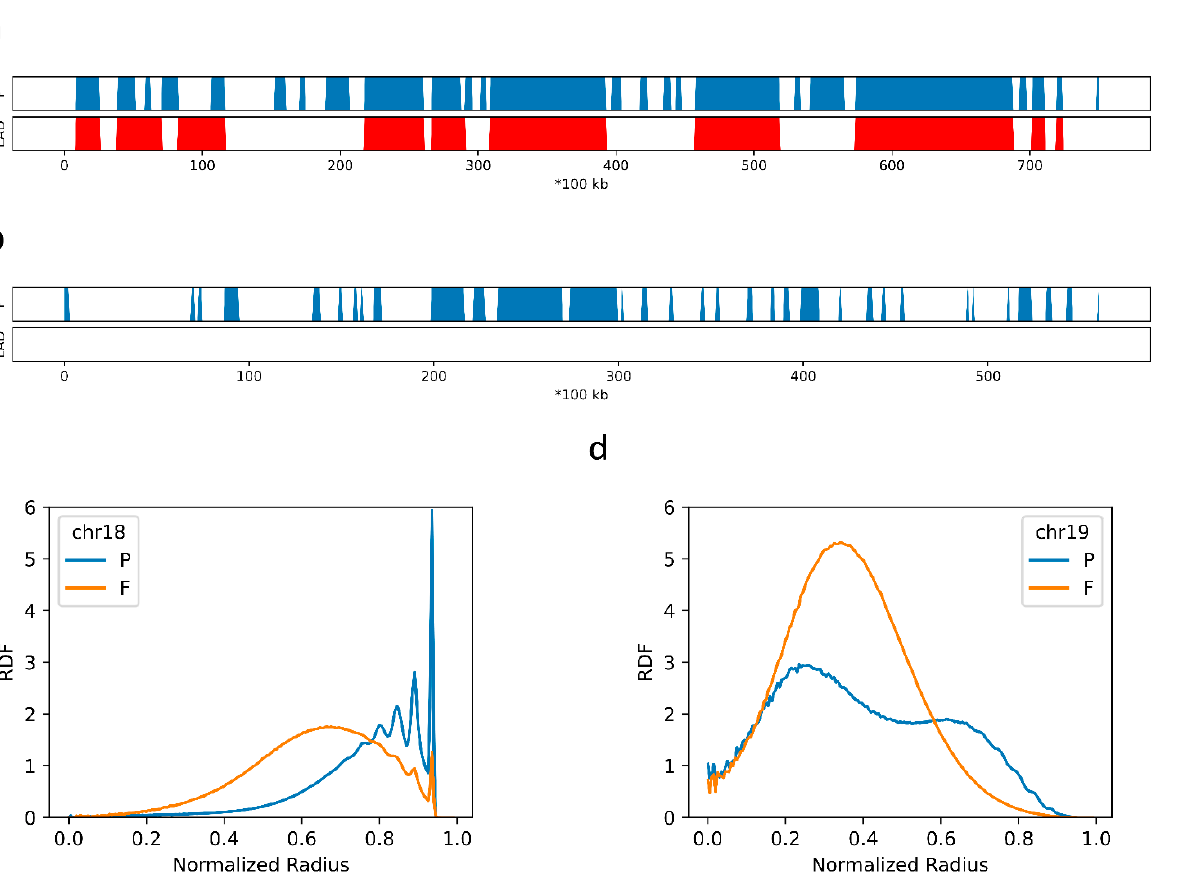
Figure 3. ( a ) The P-domain and LAD annotation of chr18; ( b ) The P-domain and LAD annotation of chr19; ( c ) the RDF obtained from the 3-chr simulation with only chr18 taken into account; ( d ) the RDF obtained from the 3-chr simulation with only chr19 taken into account.